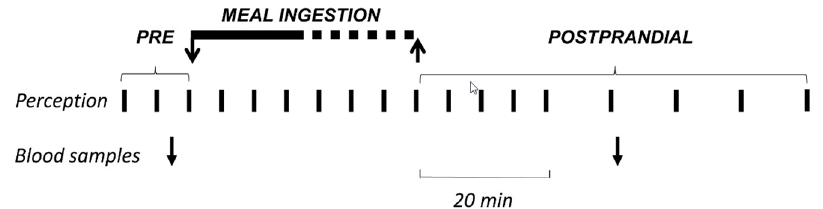
Figure 1. Experimental procedure. A comfort meal was administered at a fixed rate (150 Kcal/6 min) up to full satiation, while measuring the sensory expense at regular intervals.